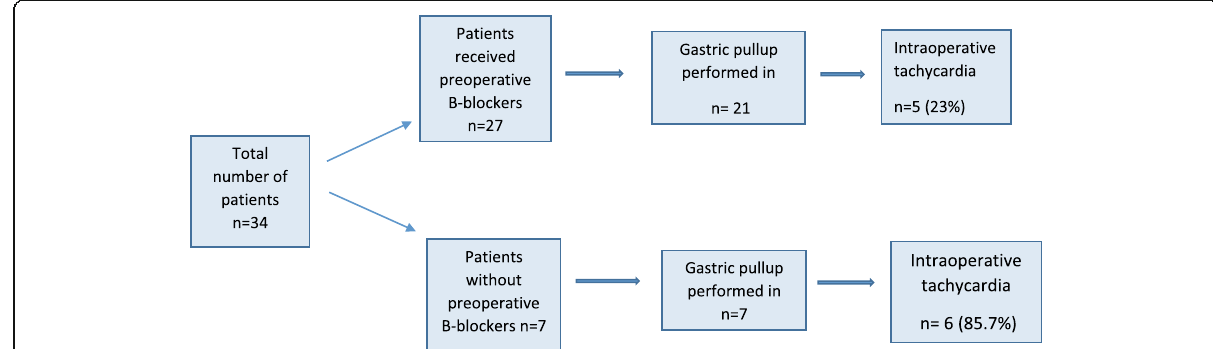
Fig. 1 Relation of pre-operative B-blockers and intraoperative tachycardia